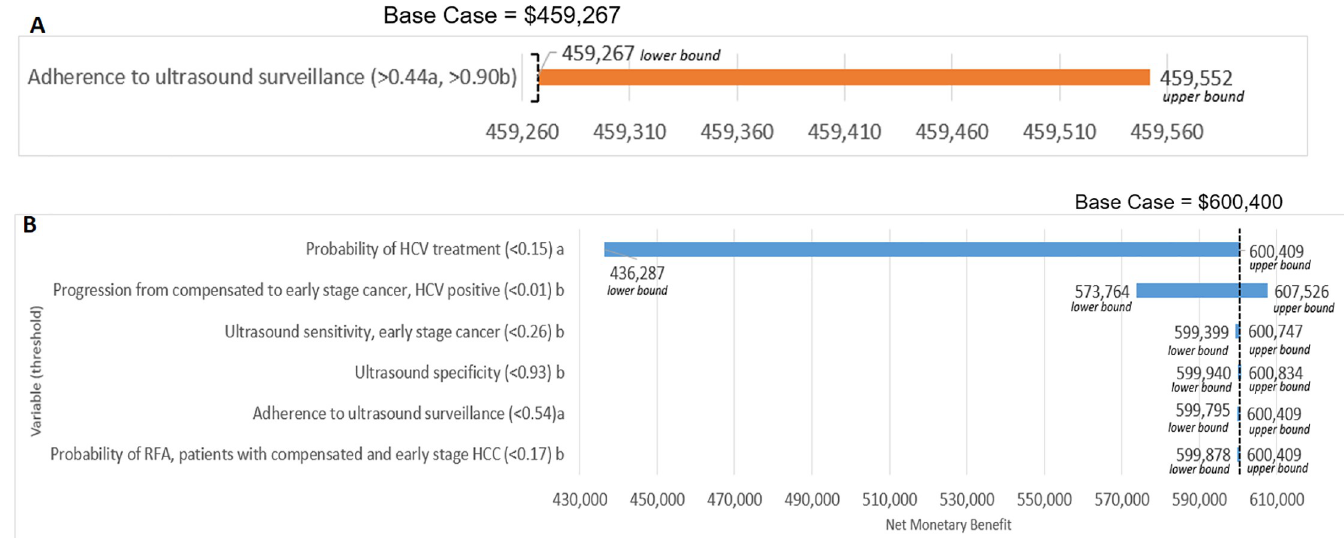
Fig 4. One-Way Sensitivity Results for the (a) Current Scenario and the (b) Aspirational Scenario. A. Results were sensitive to variation in adherence to ultrasound surveillance. Net monetary benefit is shown for the lower and upper bounds of the plausible range tested in sensitivity analysis. Thresholds for when the preference switched away from 3-month surveillance are shown in parentheses. Legend: a. When adherence was between 0.44–0.89 the preferred strategy was 6-month surveillance, b. When adherence was 0.90 or greater the preferred strategy was 12-months surveillance. B. Results were sensitive to variation for the variables shown in the figure. Net monetary benefit is shown for the lower and upper bounds of the plausible range tested in sensitivity analysis. Thresholds for when the preference switched away from 6-month screening are shown in parentheses. Legend: a. Below the threshold the preferred strategy was 3 months, b. Below the threshold the preferred strategy was 12 months.